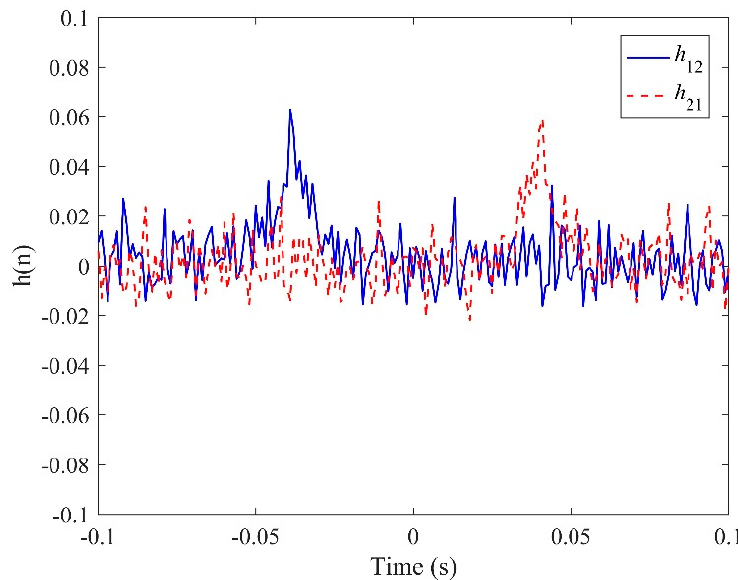
Figure 5. IRFs given by the conventional LMS adaptive